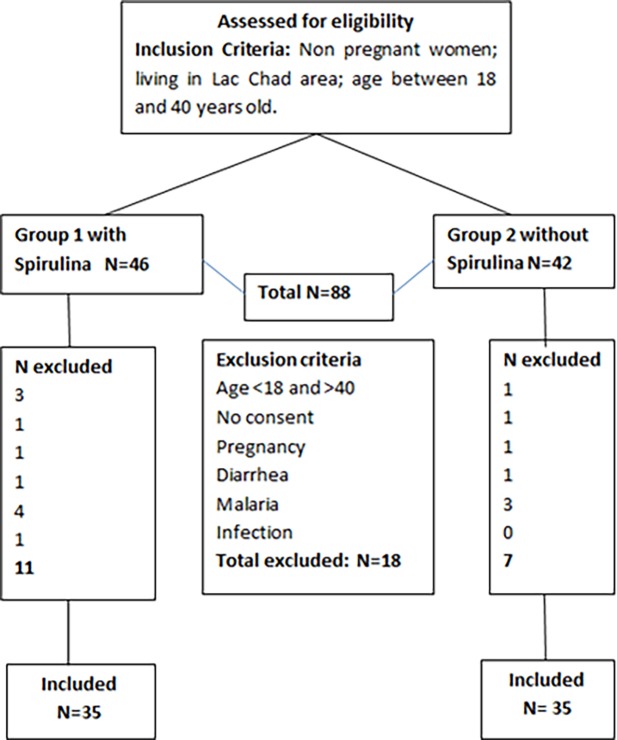
Flow chart of the enrolled women divided into the SPI+ and SPI- groups.